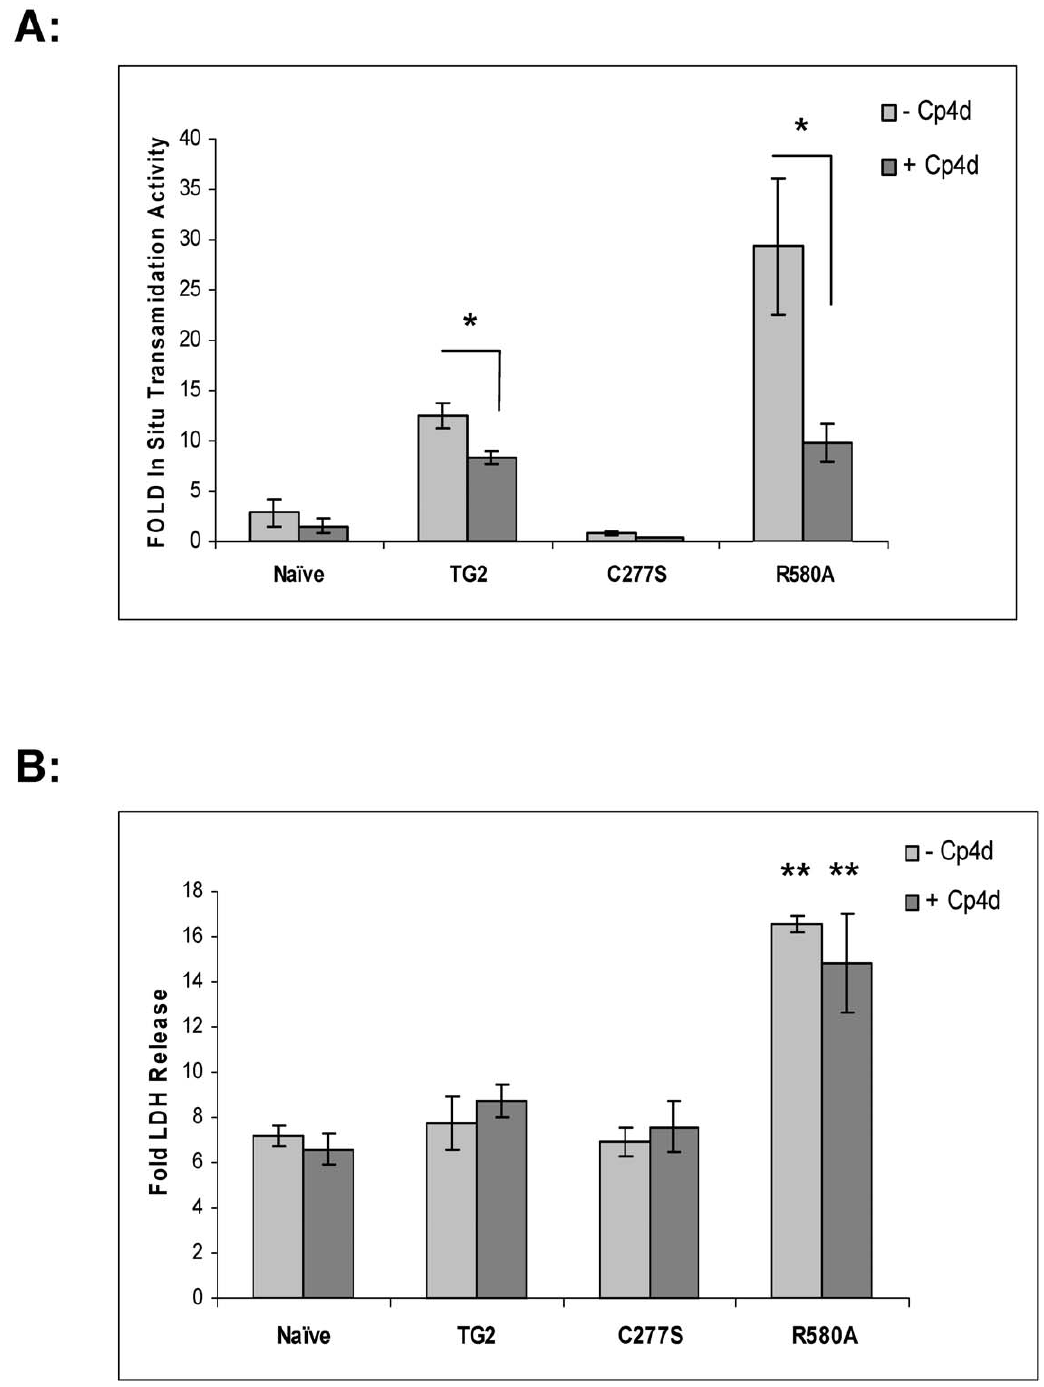
Figure 7. OGD-induced cell death with Cp4d Treatment. A , Fold increase in in situ transamidation activity in response to ionomycin treatment in the absence ( 2 ) or presence ( + ) of 20 m M Cp4d (Reversible TG2 inhibitor) in comparison to basal in situ transamidation activity of the corresponding cell line. TG2-R580A cells showed potentiation of in situ transamidation activity with 5 m M ionomycin treatment which was inhibited by Cp4d treatment (N=3) B , Fold LDH release after 36 h of OGD treatment at 0.1% O 2 in the absence ( 2 ) or presence ( + ) of 20 m M Cp4d (Reversible TG2 inhibitor) in comparison to percent LDH release amount of corresponding cell line at normoxia. None of the cell lines showed significant changes in fold LDH release with Cp4d treatment. (N=3) Results are shown as mean + / 2 SE, * p , 0.05. **p , 0.01. doi:10.1371/journal.pone.0016665.g007 In vitro and in situ transamidation activities of the stable cell lines observed in SH-SY5Y cells [2], wild-type TG2 and TG2-C277S were measured and confirmed to be as predicted according to co-immunoprecipitated with HIF-1 b . We extended these findings previous studies [8,9]. We also demonstrated that, as previously by demonstrating that TG2-R580A interacts with HIF-1 b to